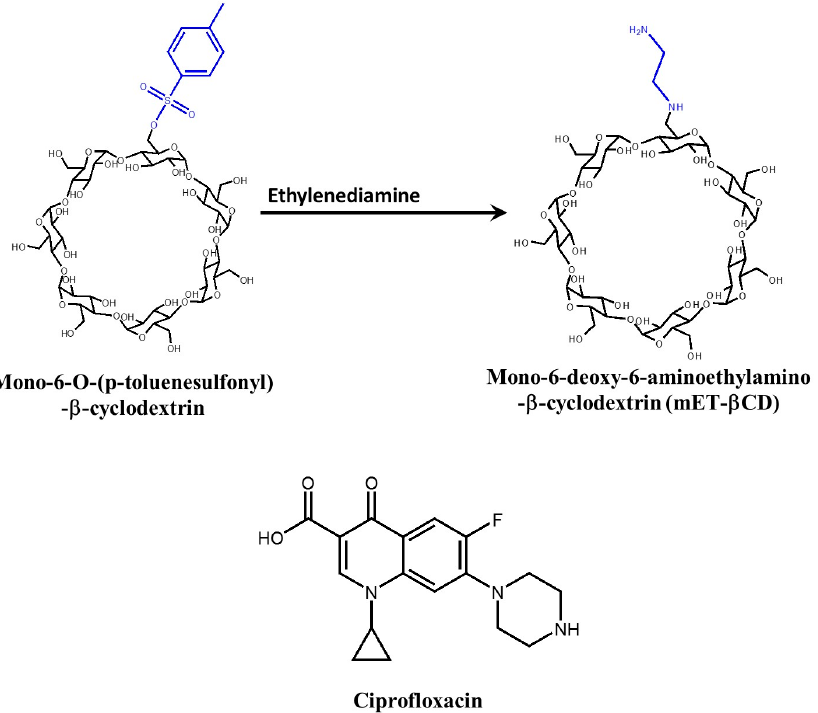
Figure 2. Synthesis of mET- β CD starting from mono-6- O -( p -toluenesulfonyl)- β -cyclodextrin and the chemical structure of ciprofloxacin.